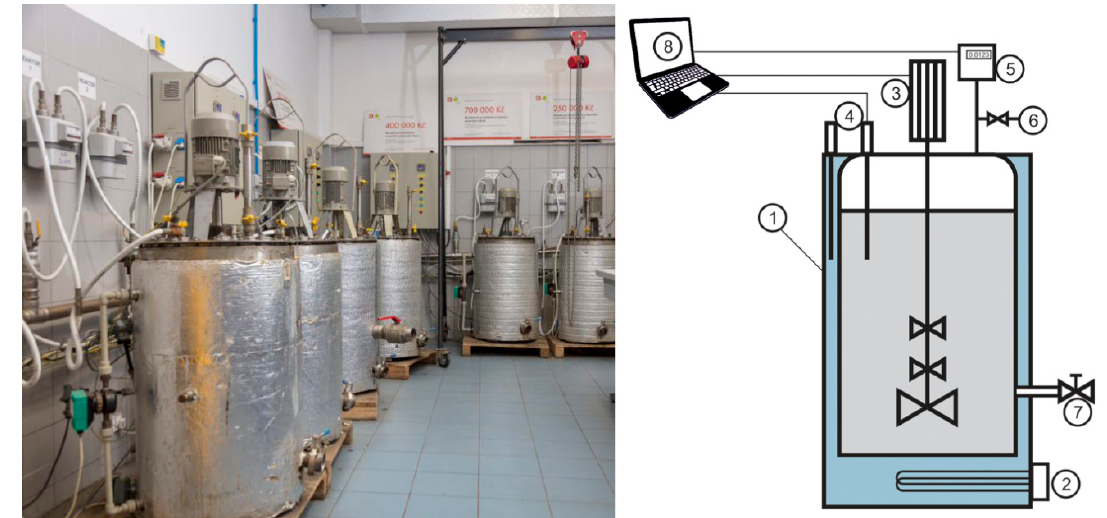
Figure 1. Lab view and fermenter scheme, (1) hot-water heating system, (2) electric heating coil, (3) electric-driven agitator with a frequency converter, (4) two temperature sensors for hot-water and fermenter content, (5) gas meter, (6) sampling point for biogas analysis, (7) sampling point for the fermented substrate and (8) computer control system.